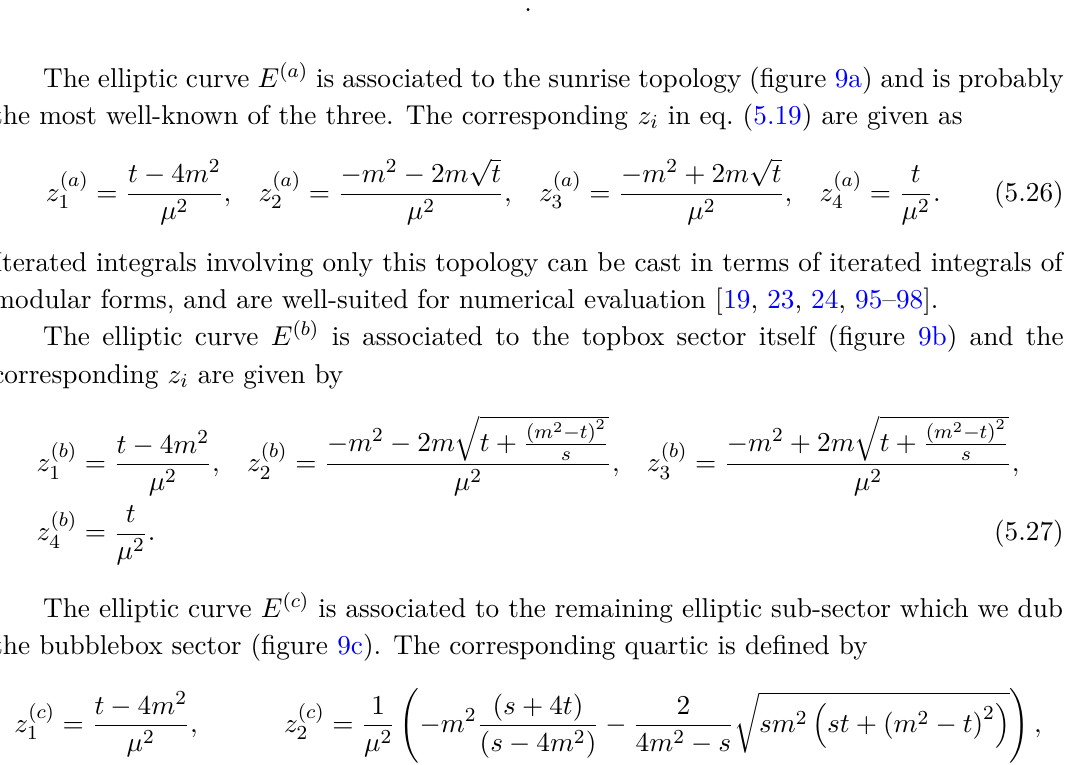
Figure 9. Topologies in the topbox family that are associated with the elliptic curves E ( a ) , E ( b ) and E ( c ) . Black-solid lines represent massive particles, red-dashed lines represent massless particles.